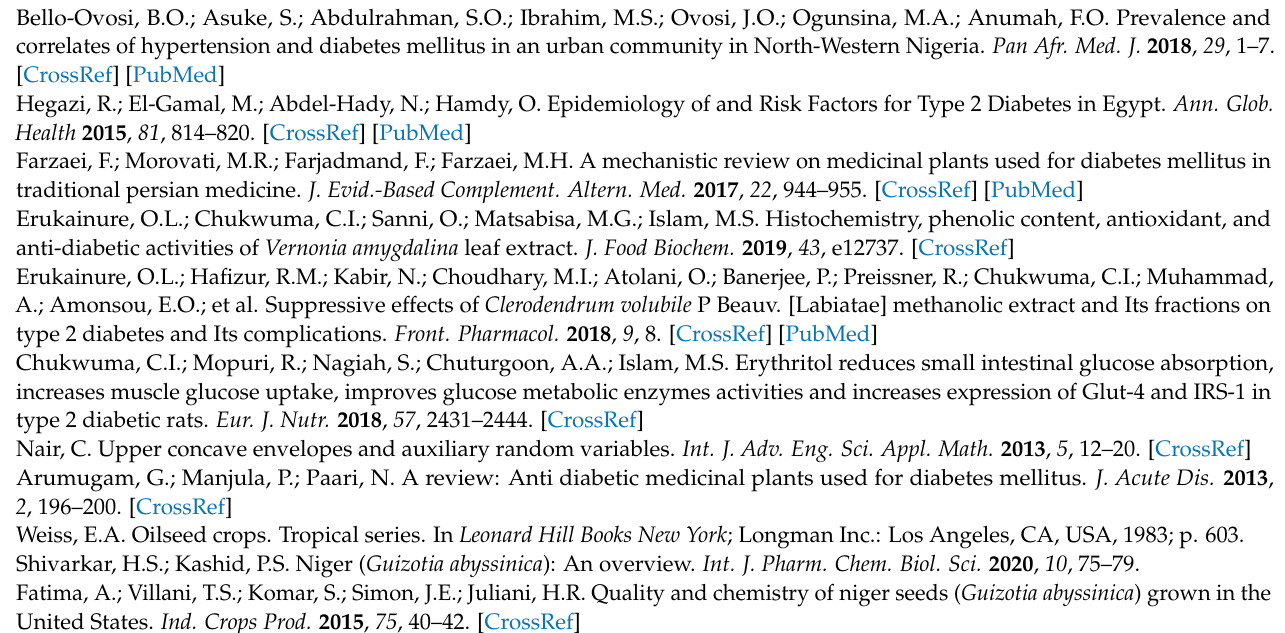
Figure S37: The effect of G. abyssinica extract and isolated compounds on accuracy of the glucose concentration assay are available in supplementary